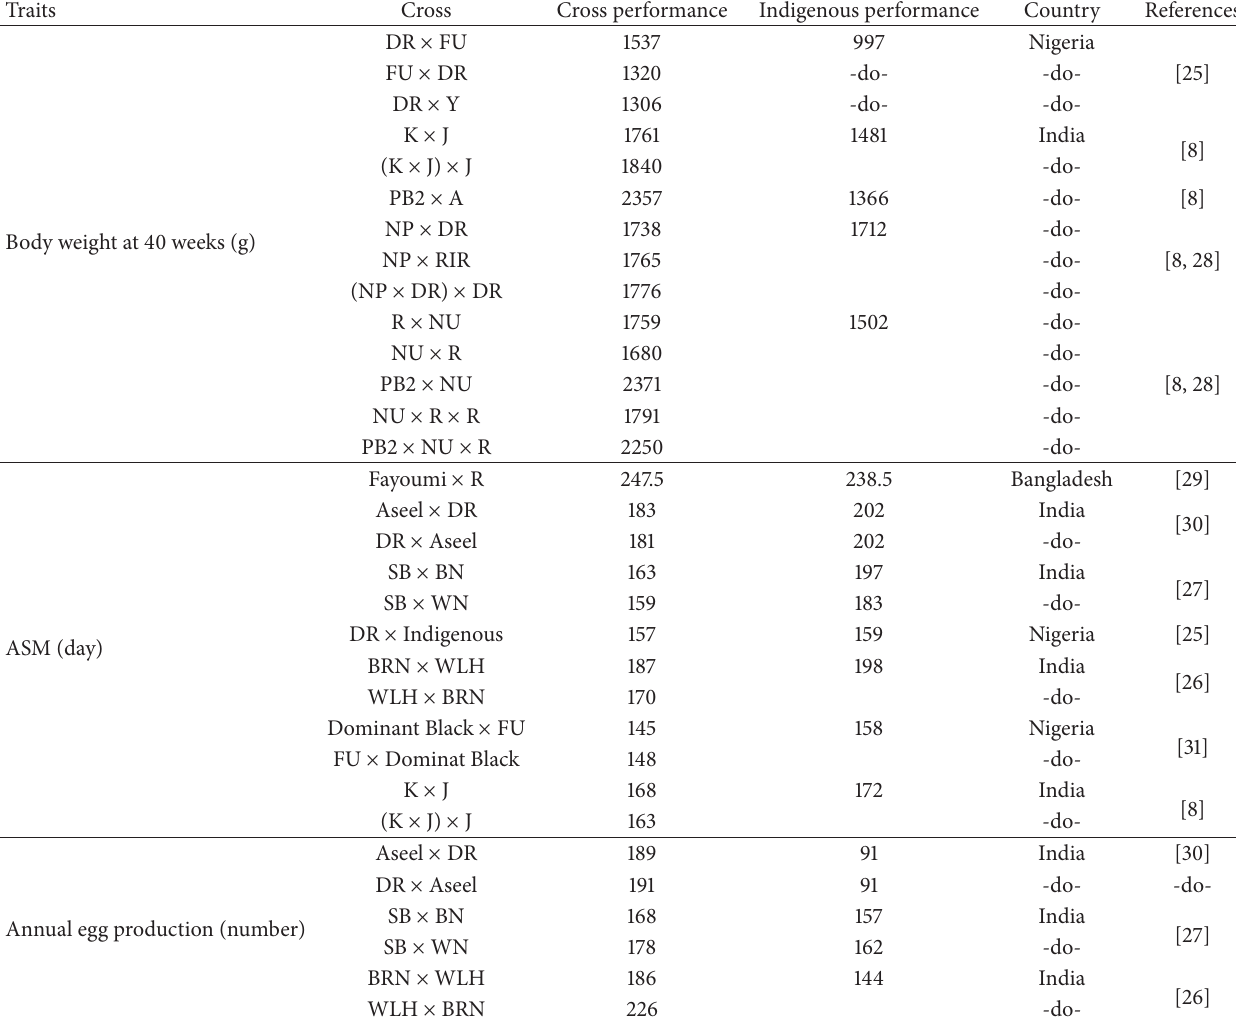
Table 3: Effect of crossbreeding using indigenous birds with respect to body weight at 40 weeks and age at sexual maturity.